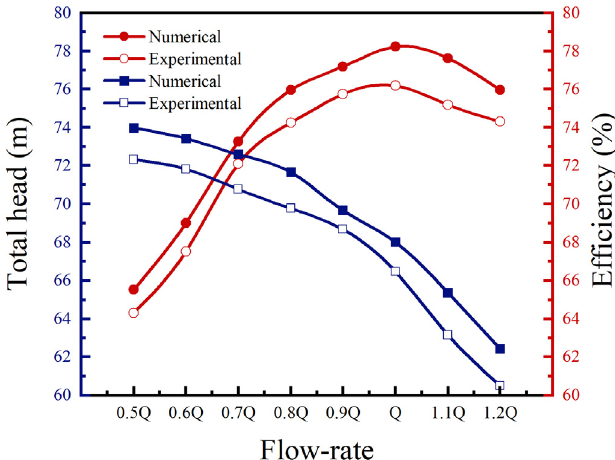
Fig. 6. Calculation results of centrifugal pump external characteristics (centrifugal pump speed is about 2955 r/min, Q is equal to 110 m